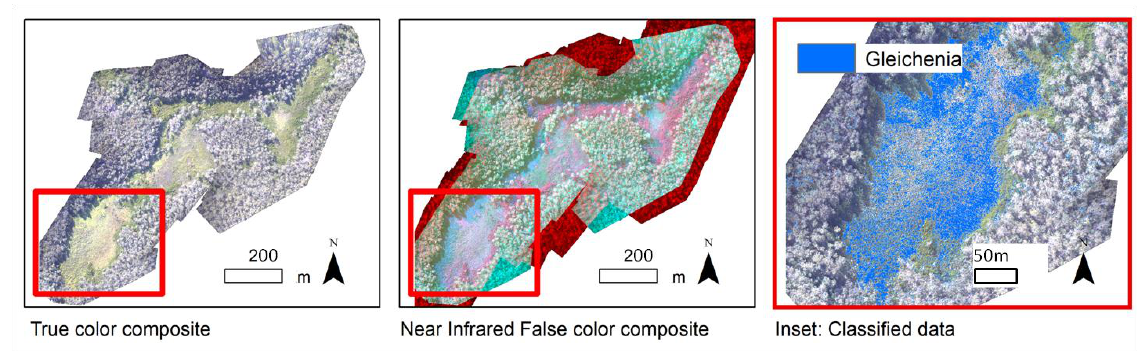
Figure 7. ( left ) True color orthomosaic; ( middle ) near infrared false colour composite (Band 1: Green, Band 2: Blue and Band 3: Near Infrared). ( right ) Subset of total swamp with classified Gleichenia microphylla overlaid on true color